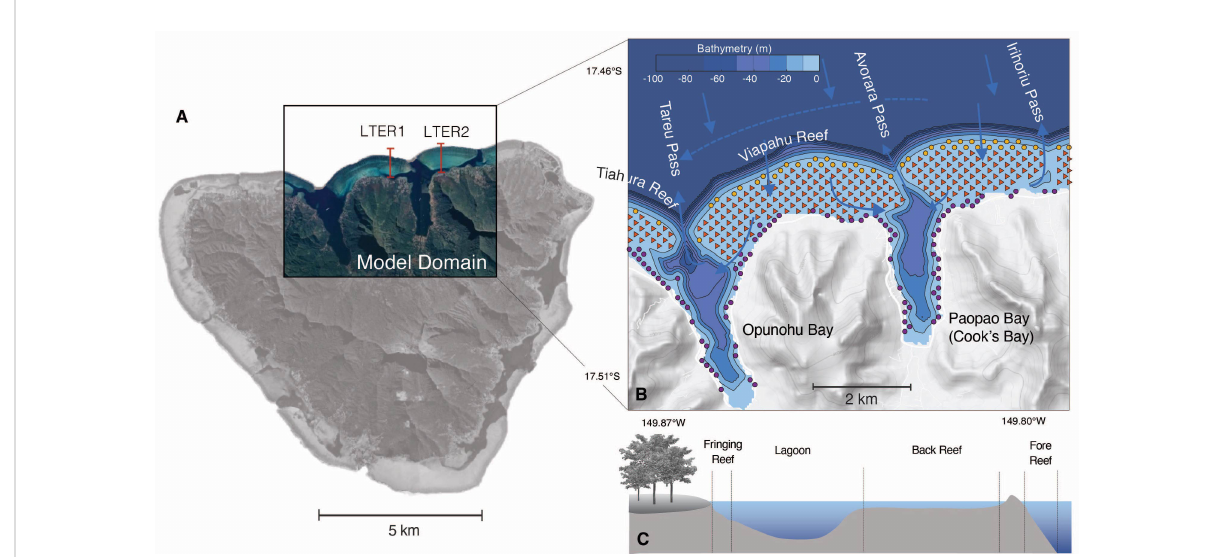
FIGURE 1 (A) Map view of Moorea island, showing the domain of the numerical model (colored inset) and the locations of the LTER1 and LTER2 stations of the Moorea LTER used in our study. (B) Map of the model domain showing the bathymetry (bluescale), the different reef types (fore reef: yellow circles, back reef: red triangles, and fringing reef: purple circles) and the names of the different bays, reefs, and passes. Also indicated with arrows is the typical circulation within and around the reef. (C) Schematic cross section across a typical reef showing the different reef types and the